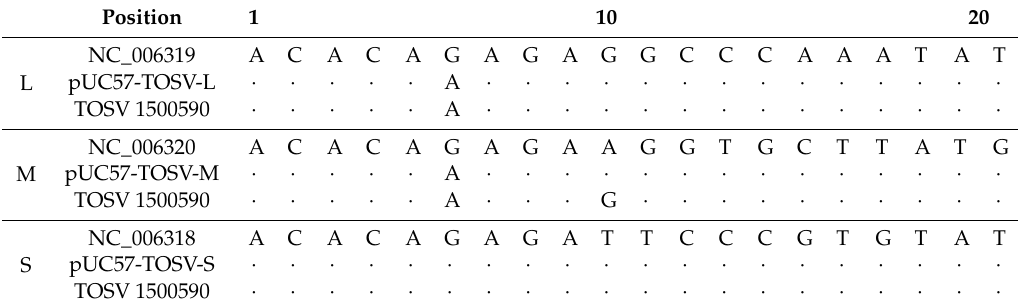
Table A3. Changes were identified in the 5 (cid:48) antigenomic UTRs of TOSV 1500590 when compared with the reference sequences.